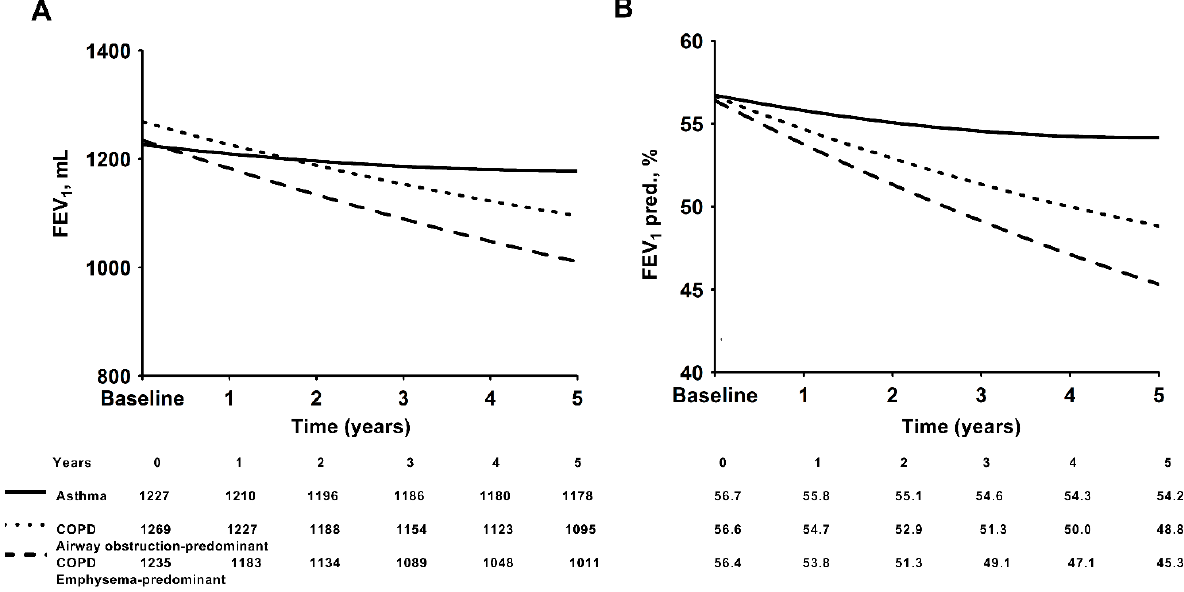
Figure 4. Modeled forced expiratory volume in one second (FEV 1 ) decline over time in milliliters ( A ) or as a percentage of the predicted value ( B ) in the three groups.